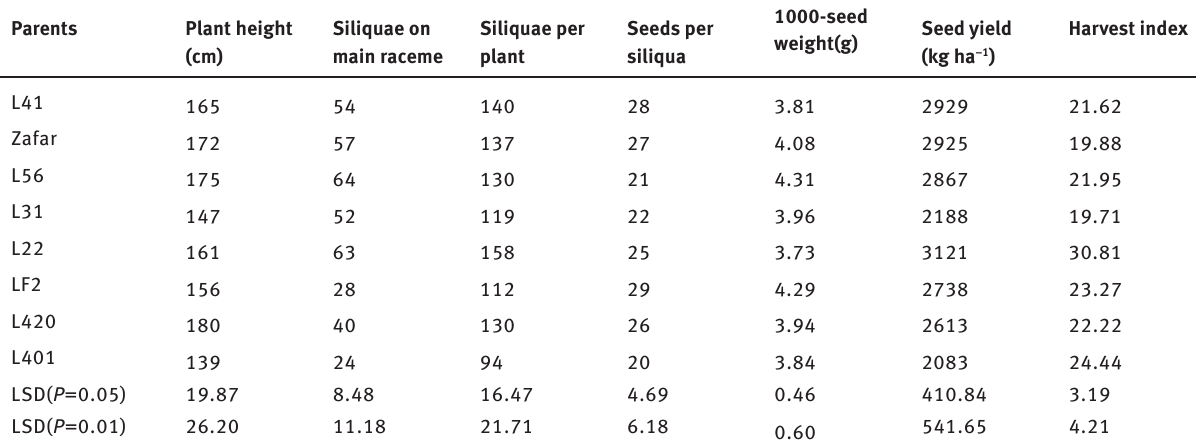
Table 2: Mean performance of yield and yield-components of eight oilseed rape genotypes